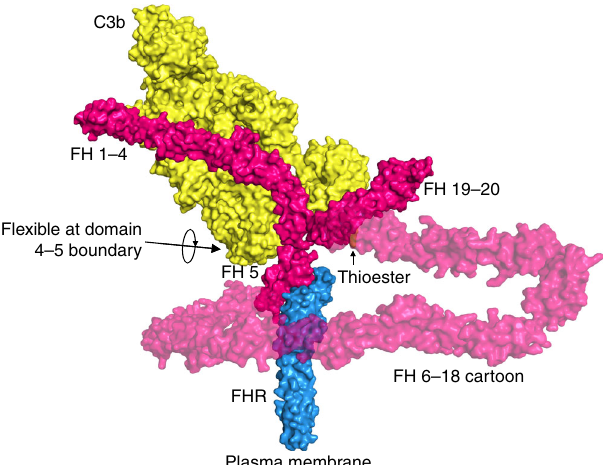
Fig. 4 FHR holds FH in a position in which it can access surface-bound C3b. A cartoon model for how the FHR (blue) could hold FH (pink) distal to the plasma membrane, to interact with C3b (yellow). The model combines the FHR:FH domain 5 structure with previously determined structures PDB 5O35 and